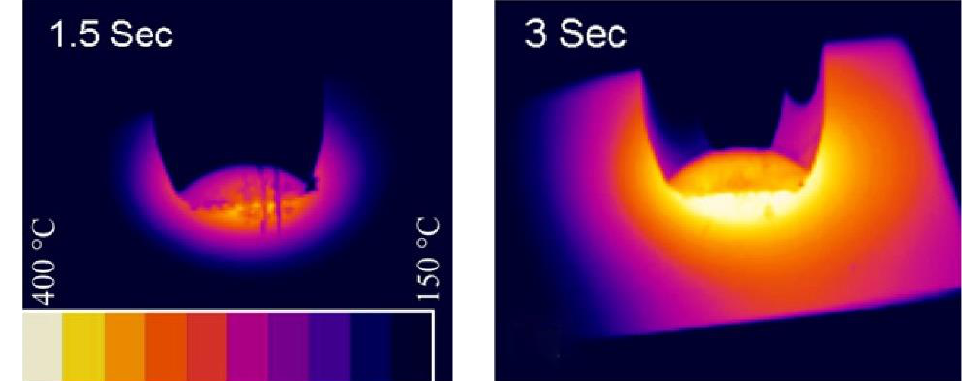
Figure 7. Temperature field according to thermal imaging at the welding time of 1.5 s and 3.0 s [33]. Wang et al. [34] found no obvious changes in the interface temperature by changing the specimen placed direction (vertical to or parallel to the vibration direction), since the frictional heat between the sonotrode and the workpiece has not changed, as shown in Figure 8. Satpathy et al. [22] reported that the interface temperature of the AA3003 alumi- num alloy/304 stainless steel joint was significantly increased by inserting the Cu inter- layer. Moreover, the peak temperature of dissimilar joints with interlayer reached its max- imum of 592 °C due to increased friction caused by the Cu interlayer.